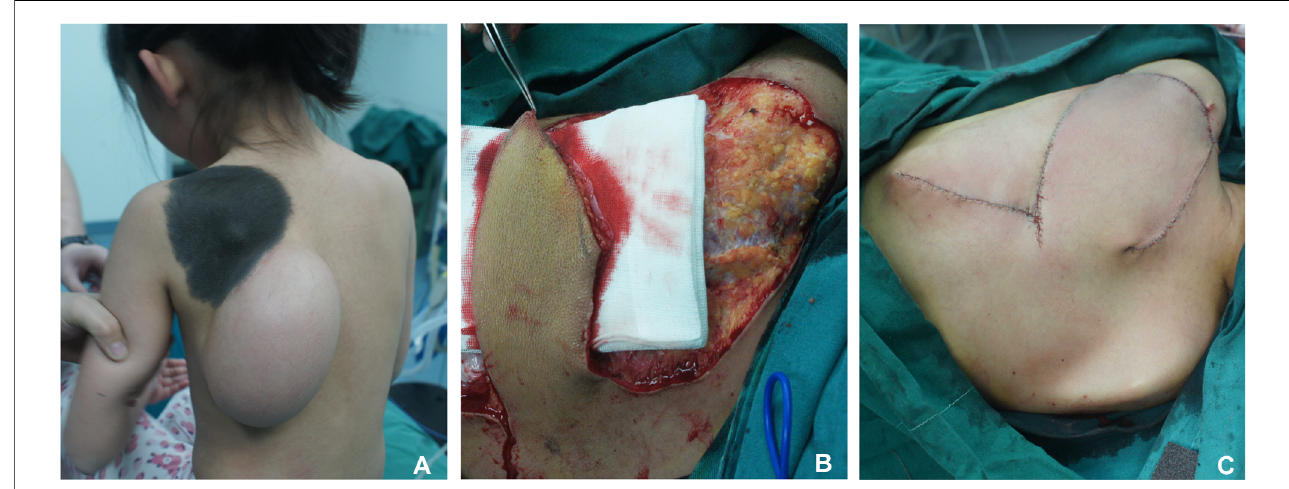
FIGURE 5 Skin incision was made along the designed line on the expanded fl ap, and length-to-width ratio of the fl ap was 1:3. ( A ) Preoperative appearance. ( B ) Length- to-width ratio of the fl ap was 3:1. ( C ) Immediate postoperative appearance.